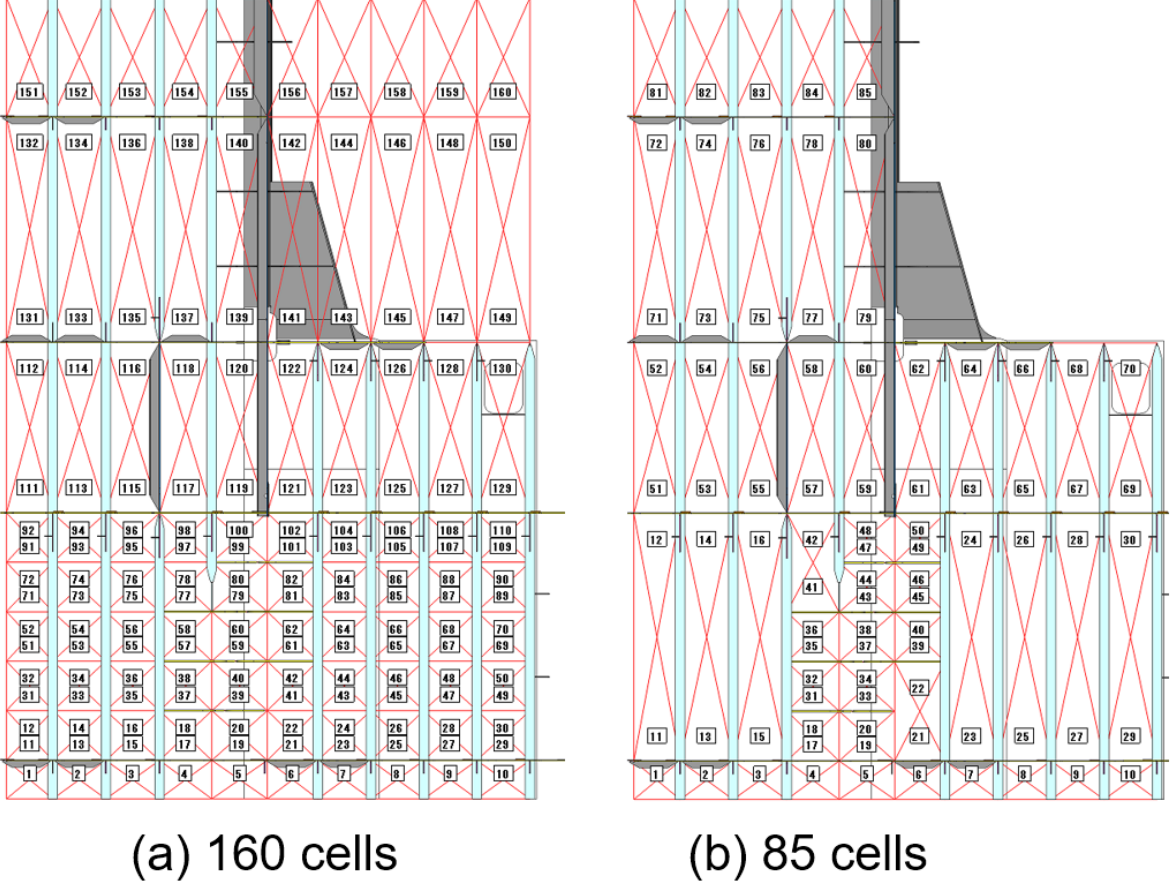
Figure 12. Cell generation and merging.